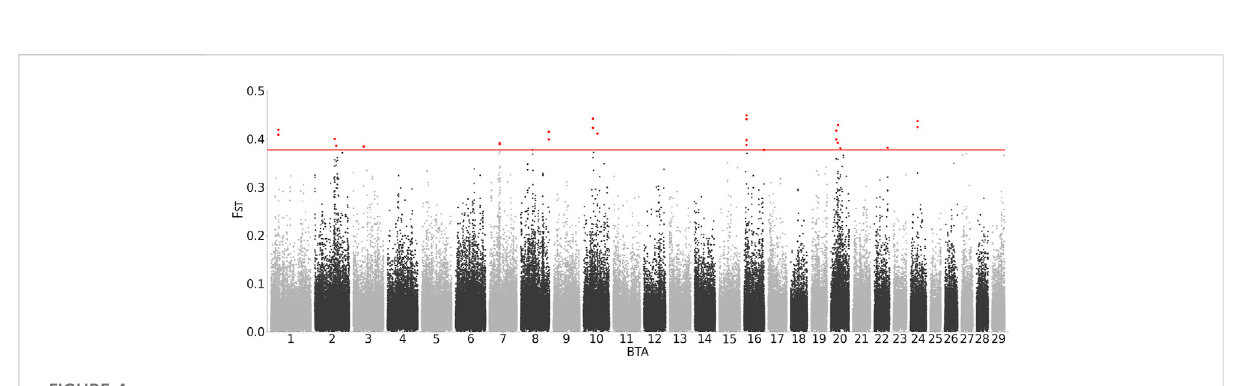
FIGURE 4 Region-wide F ST between DSN and Holstein. All values were plotted in windows of 10